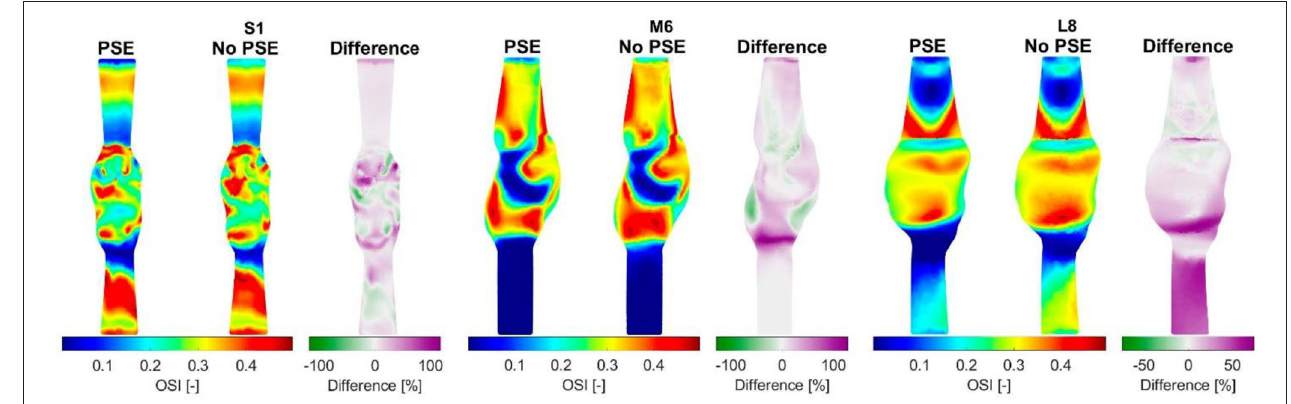
FIGURE 10 | Visualization of the oscillatory shear index (OSI) resulting from the FSI simulations with and without PSE, and the difference in OSI for patients S1, M6, and L8.